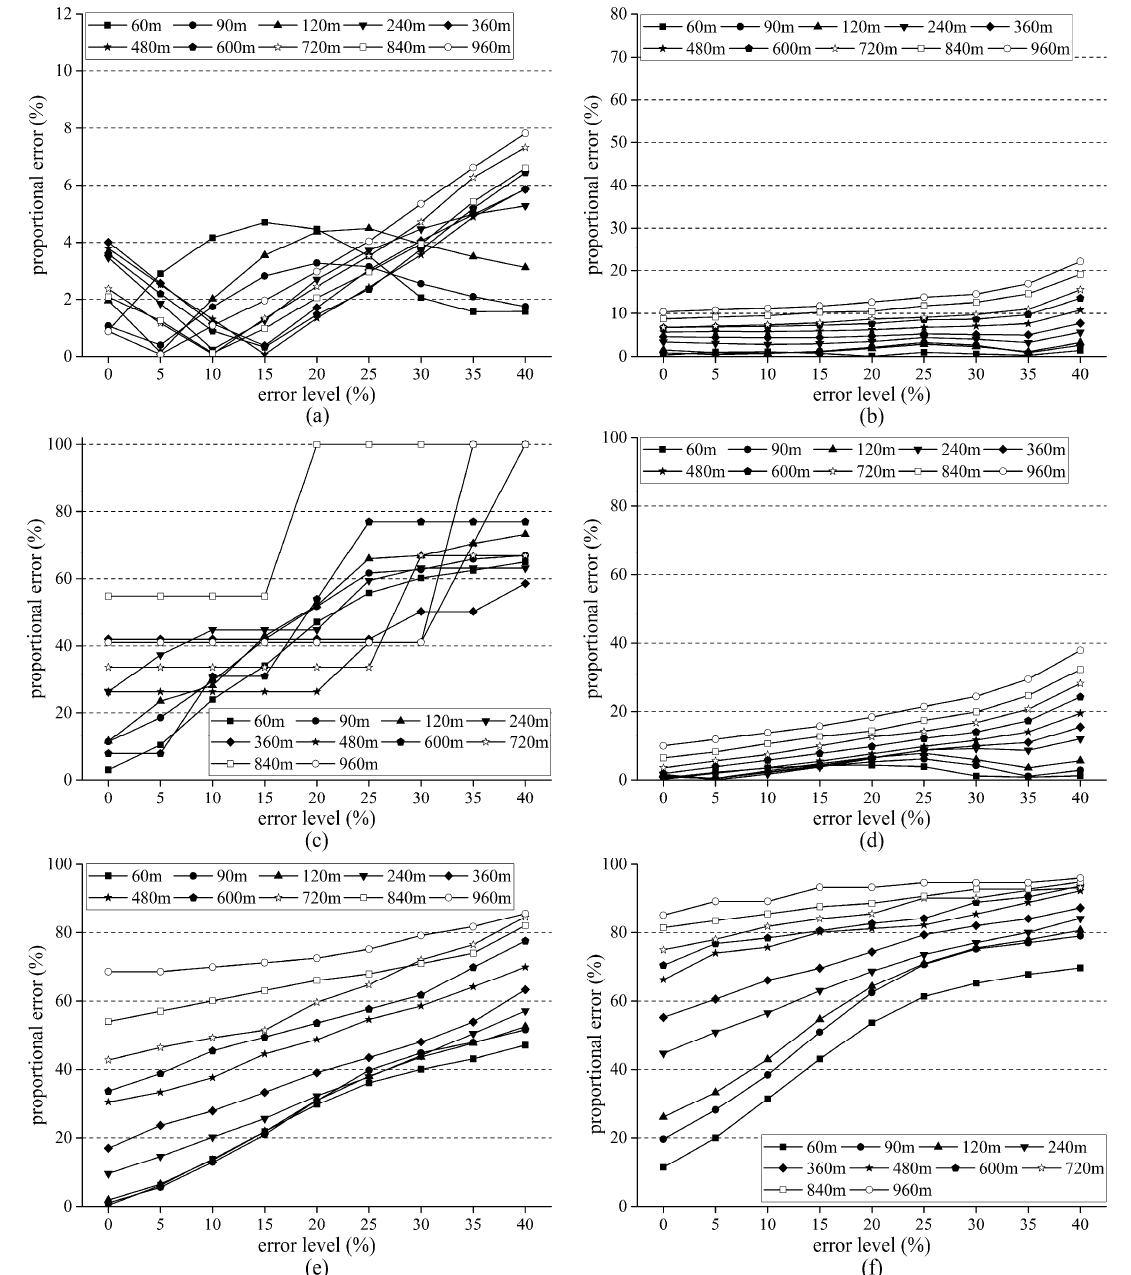
Figure 6. Changes in proportional error (PE) for each crop type at different resolutions with increasing base map error at ASD1810: ( a – f ) PEs of the non-crop, corn, sorghum, soybeans, winter wheat, and alfalfa, respectively.